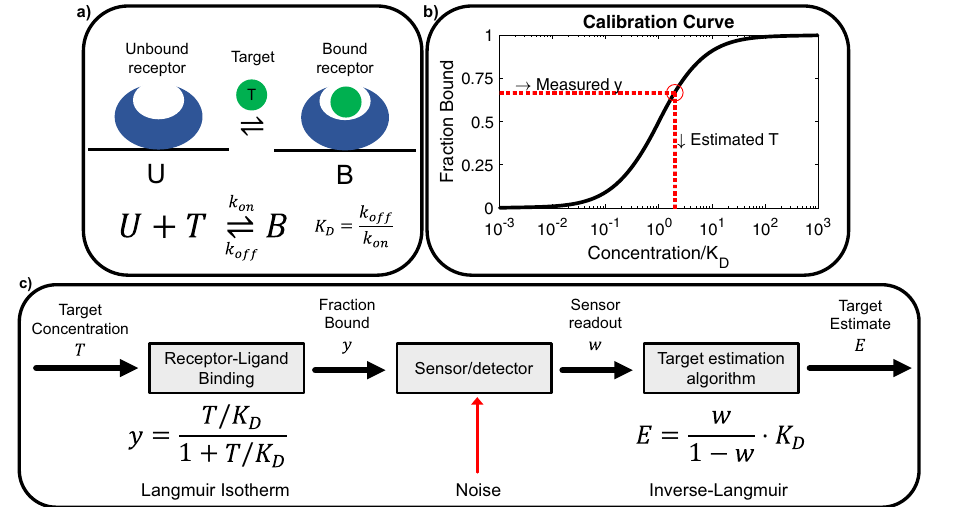
Fig. 1 | Equilibrium measurements with bimolecular sensors. a A molecular receptor operating under the bimolecular assumption, where the equilibrium between unbound state U and bound state B is determined by the target con- centration T . The binding properties of this receptor are described by the kinetic parameters k on , k off . b At equilibrium, the concentration of target ( T ) is back-